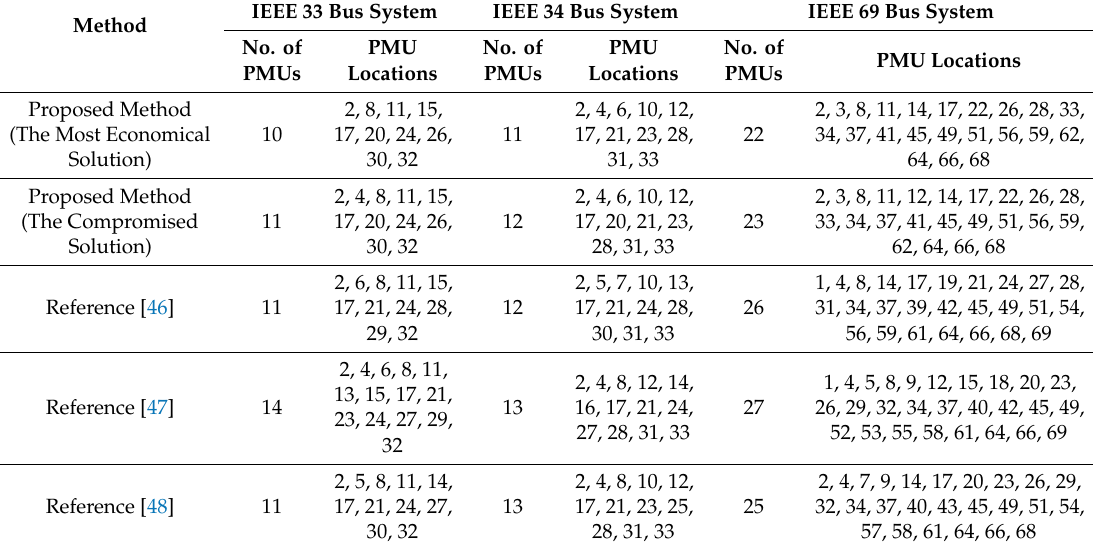
Table 2. Comparison of optimal solutions in IEEE Standard Bus Systems.